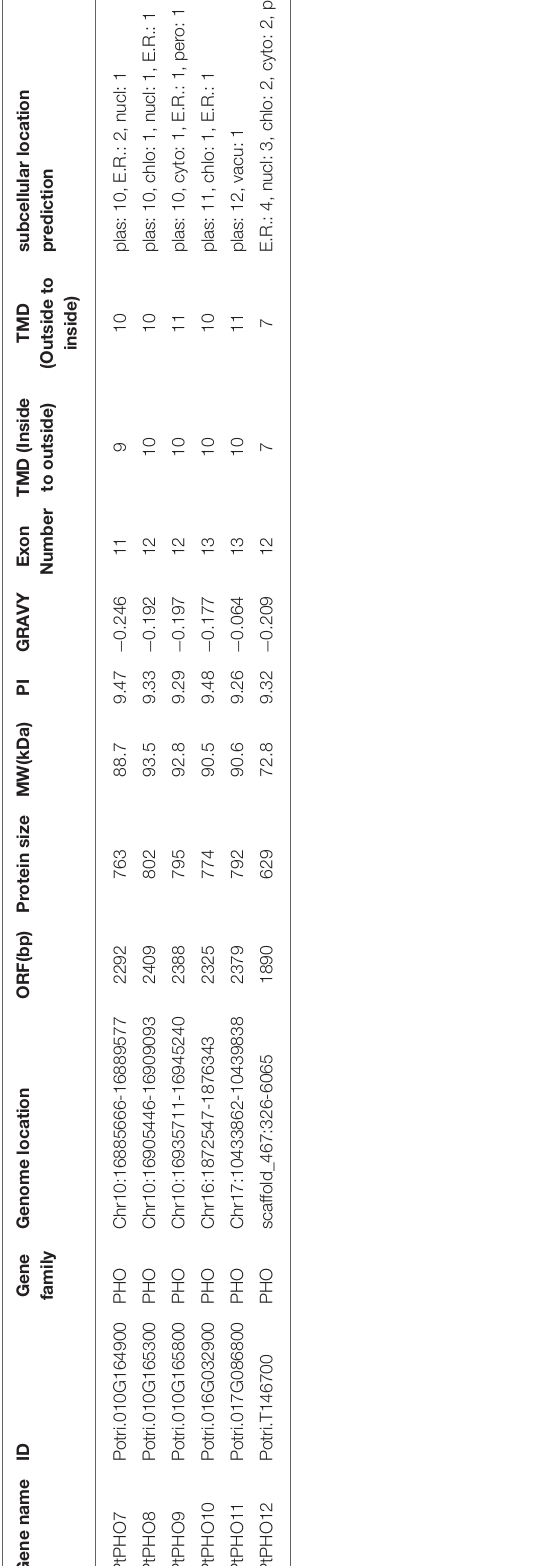
cis -Regulatory Elements of PtPHT Genes in Poplar The 2 kb upstream regions of the 42 PtPHT genes were analyzed using PLACE signal scan program. A total